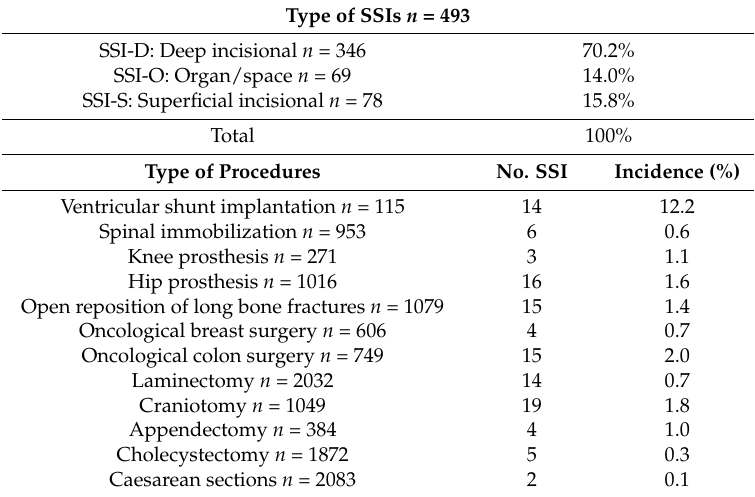
Table 3. Characteristics of surgical site infections (SSIs) and incidence rates associated with procedure types.